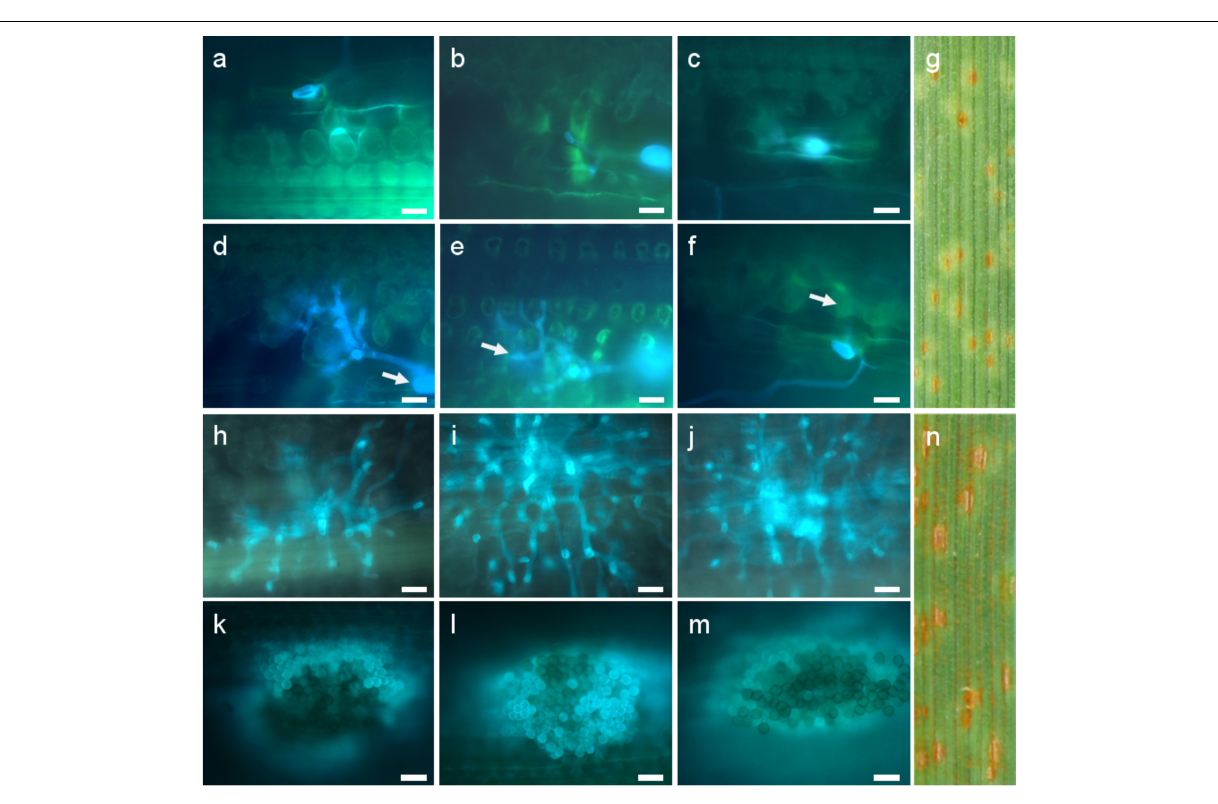
FIGURE 4 | Development of fungal structures in the resistant hybrid genotype 1 (a–f) and the susceptible hybrid genotype 12 (h–m) after inoculation with isolate 1 (a,d,h,k) , isolate 2 (b,e,i,l) , and isolate 3 (c,f,j,m) at the seedling stage. Macroscopic symptoms on leaf segments 8 days after inoculation with isolate 4 (g,n) and microscopic observations 72 hai (a,b,c,h,i,j) and 168 hai (d,e,f,k,l,m) are compared. Arrows indicate substomatal vesicle (d) , haustorial mother cell (e) , and autofluorescence around infection sites (f) . Scale bars 20 µ